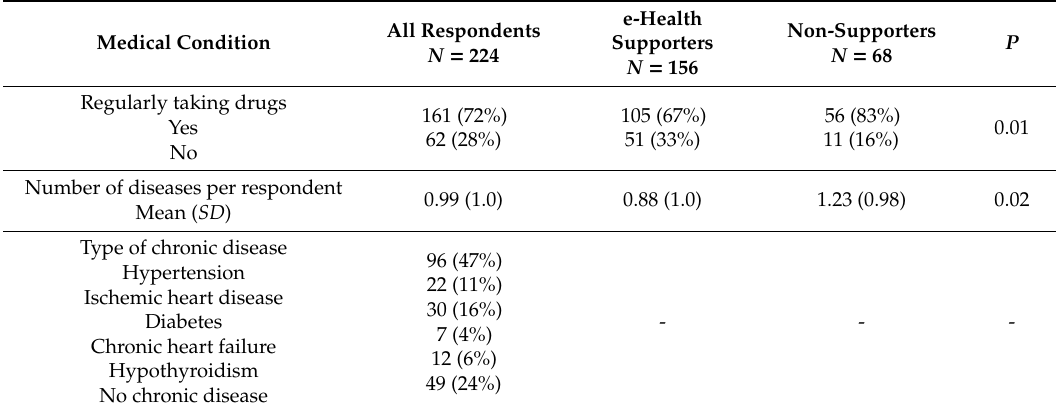
Table 3. Medical condition of the respondents.